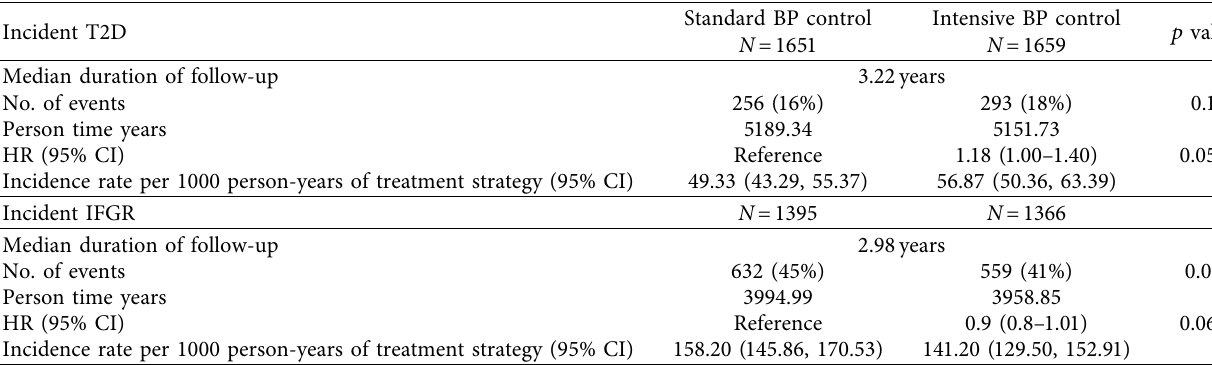
Table 2: Incident outcome events by two treatment